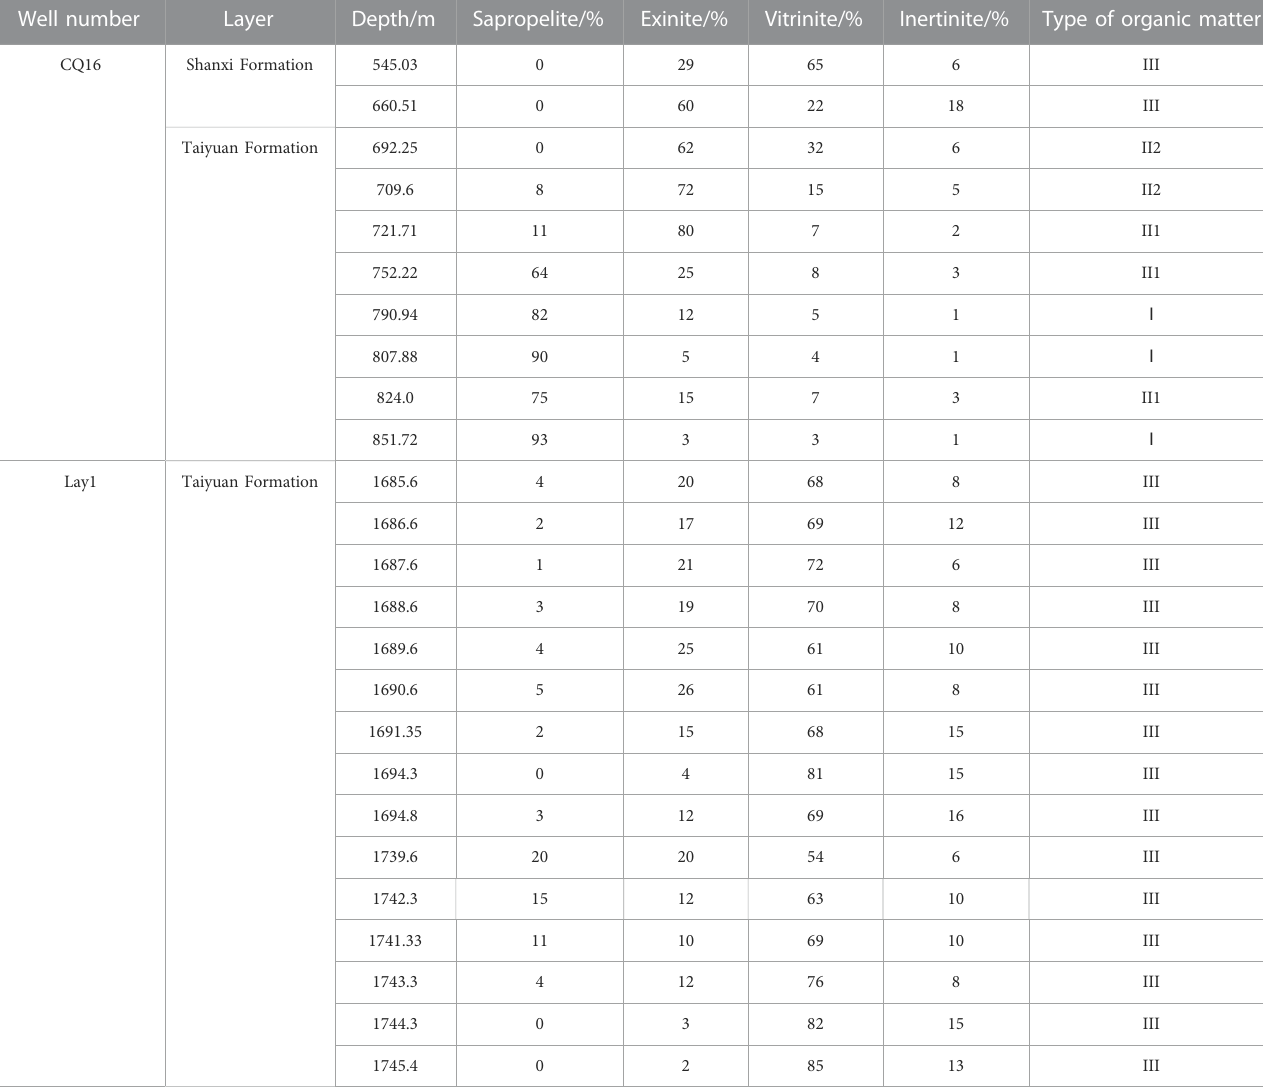
TABLE 2 Maceral content of shale in Wells Cq16 and Lay1. Well